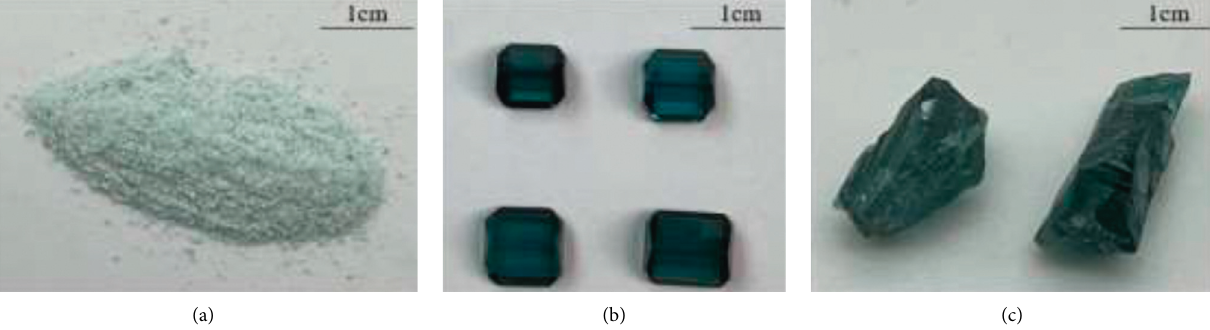
Figure 1: Tourmaline samples: (a) powder, (b) faceted stones, and (c) crystal fragments.